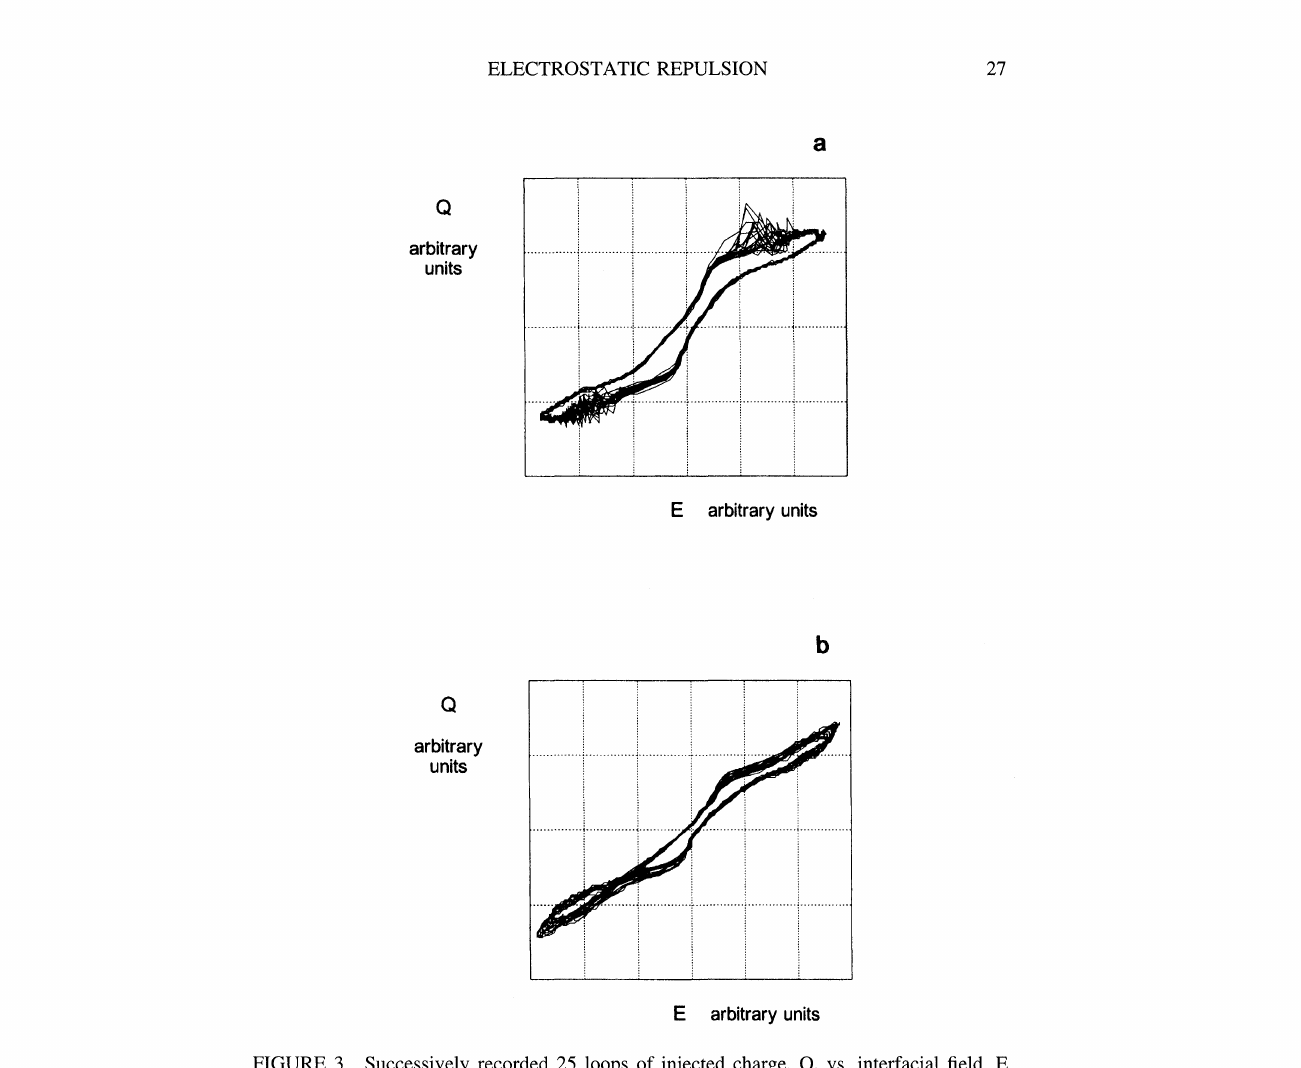
FIGURE 3 Successively recorded 25 loops of injected charge, Q, vs. interfacial field, E, across highly oxidised copper-brass contacts sustaining 200 A rms-50 Hz currents. (a) Laboratory environment. (b) High vacuum (10 -6